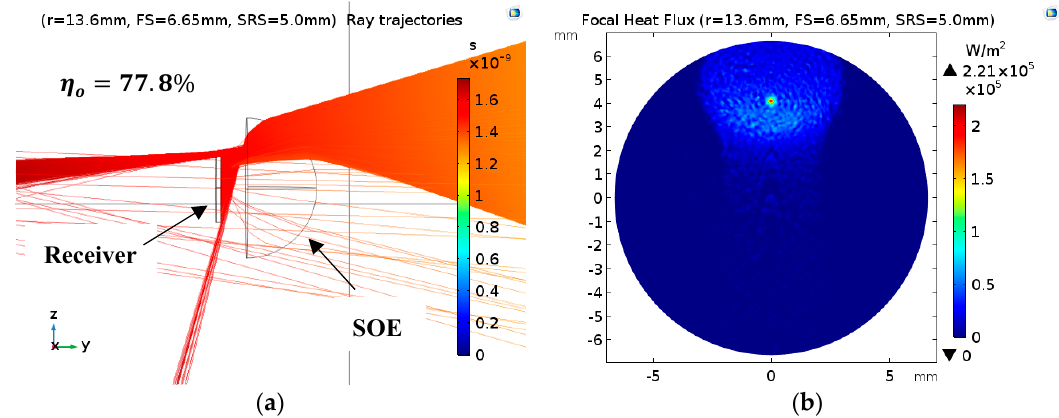
Figure 6. For Case 1: ( a ) ray trajectories through the optimum SOE parameters of this work at the acceptance angle of 1.15° and ( b ) the receiver’s irradiance distribution in W/m 2 at the acceptance angle of 1.15°.